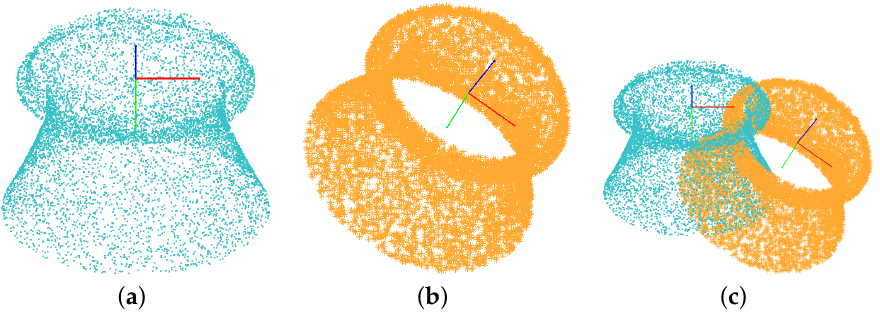
Figure 4. This is target point cloud and the point cloud to be registered. ( a ) The target point cloud. ( b ) The point cloud to be registered. ( c ) The initial coordinate system of two point